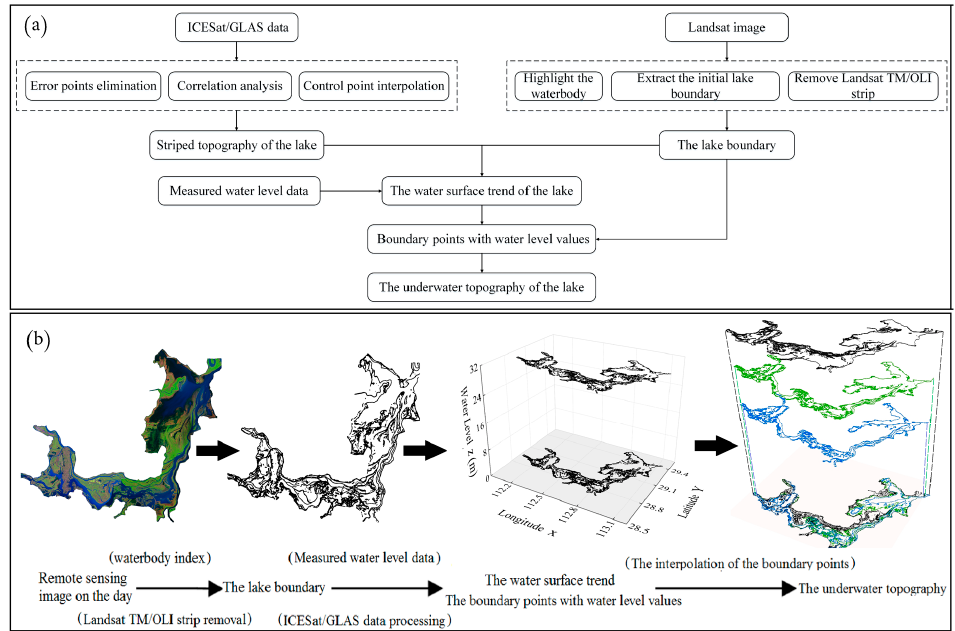
Figure 2. Diagram of terrain computation principle: ( a ) technical roadmap, ( b ) process diagram.